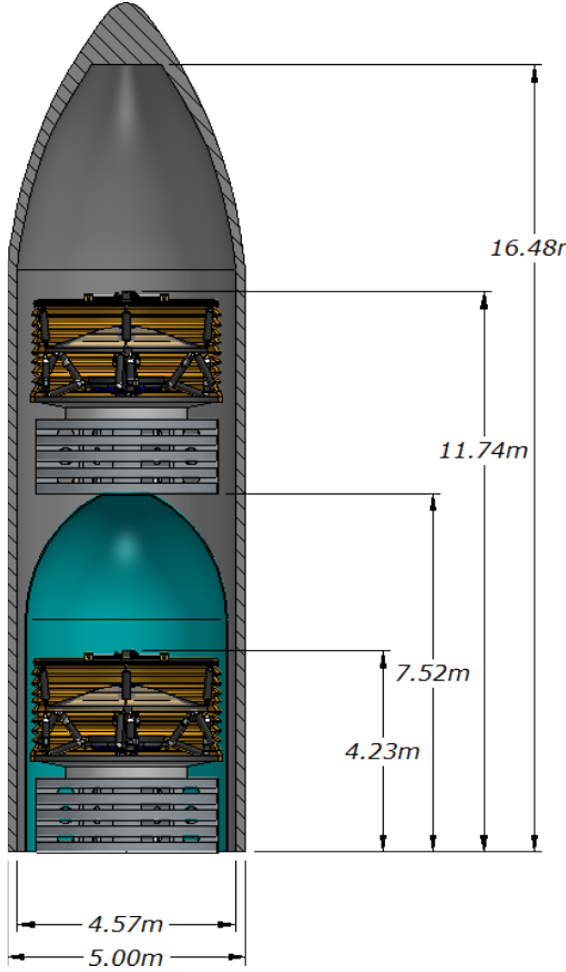
Figure 5. A schematic of the POEMMA satellites in a stowed configuration in dual manifest Atlas V launch